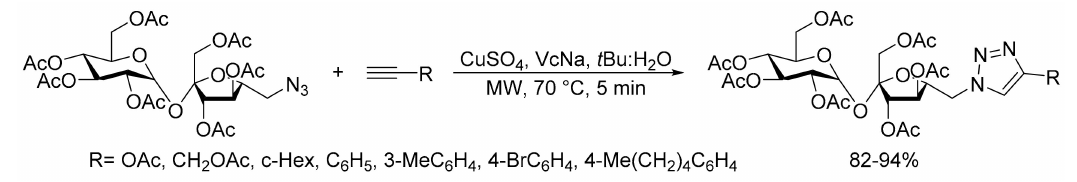
Scheme 22. CuSO 4 catalyzed microwave assisted synthesis of 1,2,3-triazole-sucrose derivatives. The copper(I)-catalyzed azide-alkyne cycloaddition (CuAAC) has gained